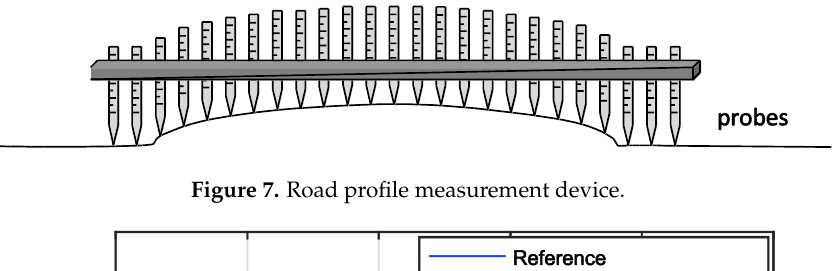
Figure 7. Road profile measurement device.